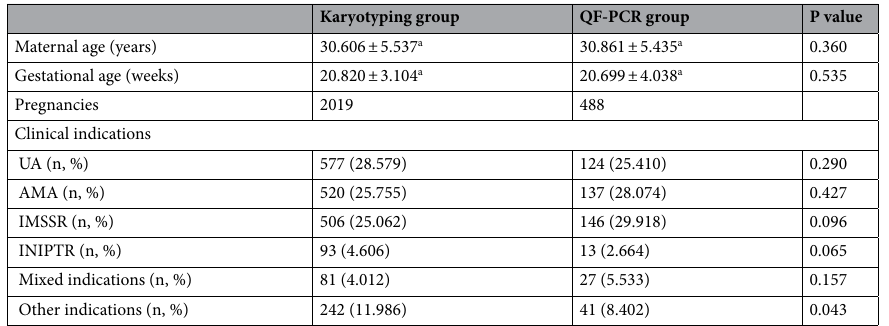
Table 1. Clinical characteristics of pregnancies in the karyotyping and QF-PCR group. UA, ultrasound abnormalities; AMA, advanced maternal age; IMSSR, increased maternal serum screening risk; INIPTR, increased NIPT risk. Other indications included previous fetus/child with genetic or phenotypic abnormalities, carriers of monogenic genetic diseases, medication during pregnancy, embryos stop developing, intellectual disability of pregnant women. a Gestational age and maternal age were expressed as mean ± SD.